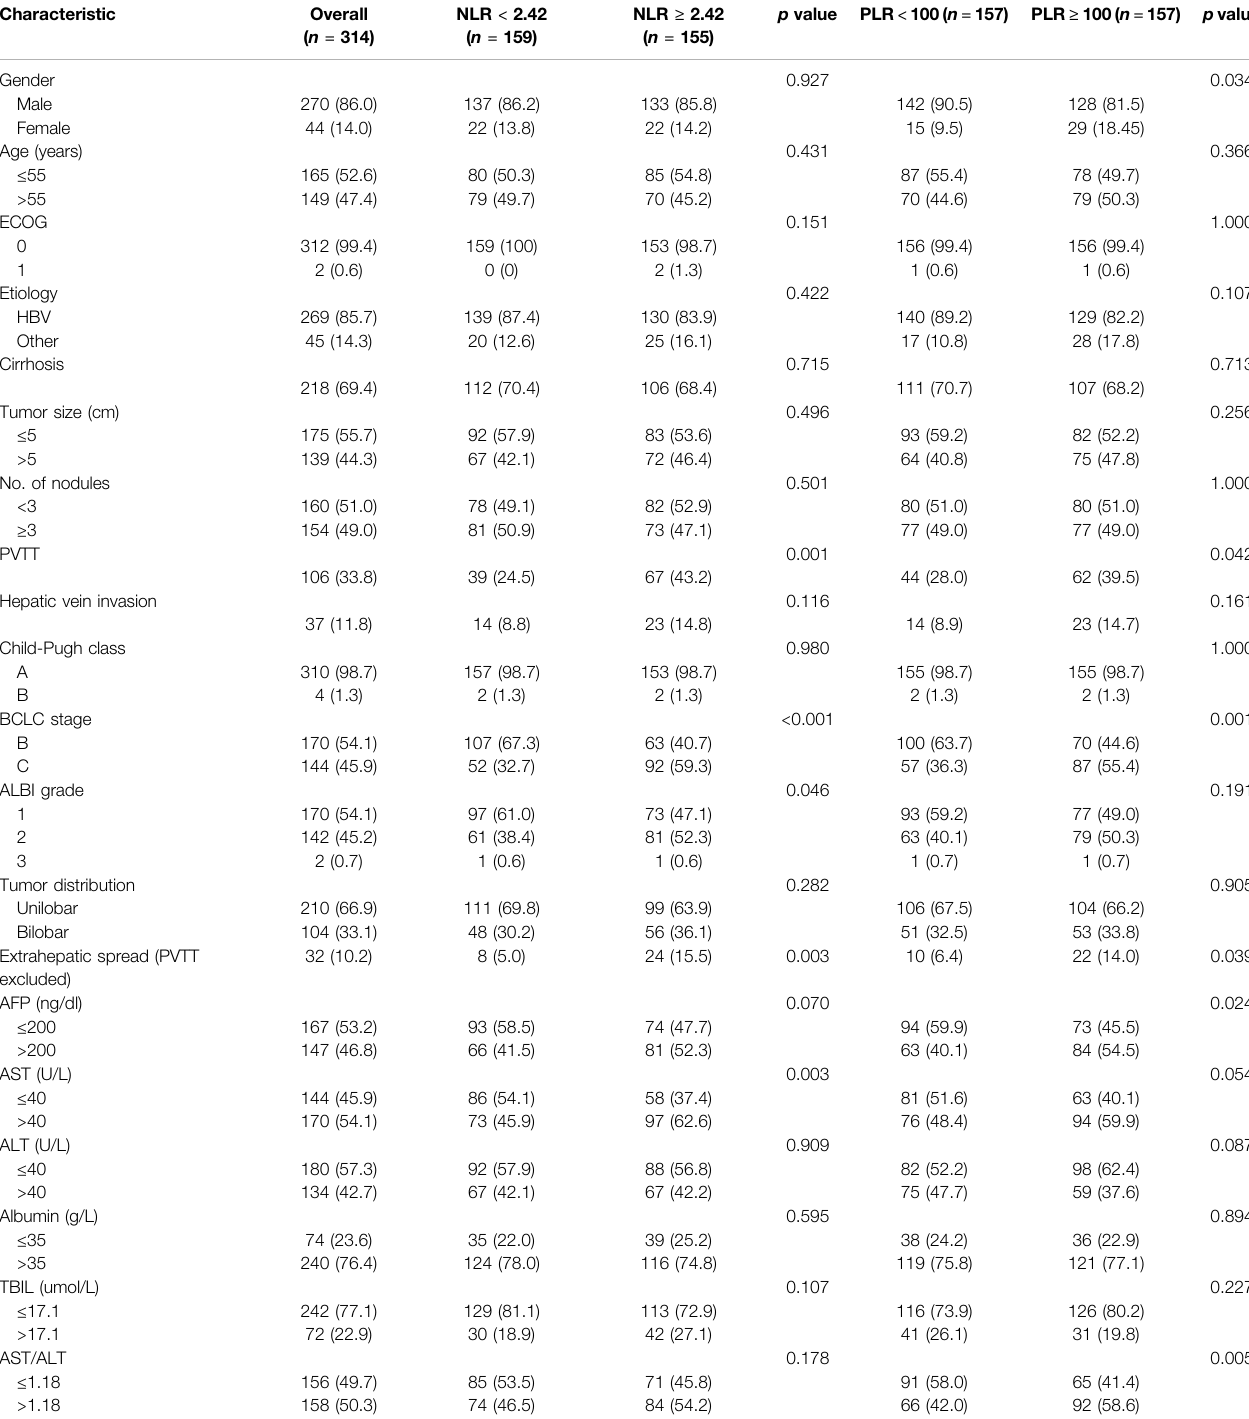
TABLE 1 | Comparison of the clinic-laboratory data and demographic features between patients with 1) low NLR and high NLR and 2) low and high PLR. Characteristic Overall ( n =